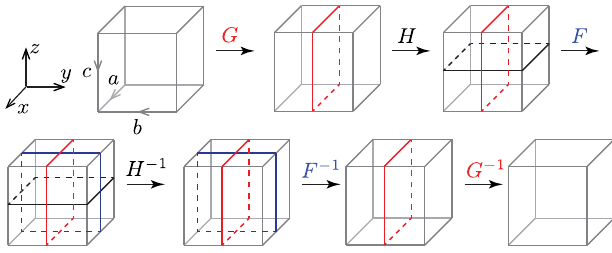
FIG. 11. Time sequence for process h G − 1 F − 1 H − 1 FHG i . The worldsheets in this process share the same topological properties as the three-flux-loop braiding process in Fig. 3.